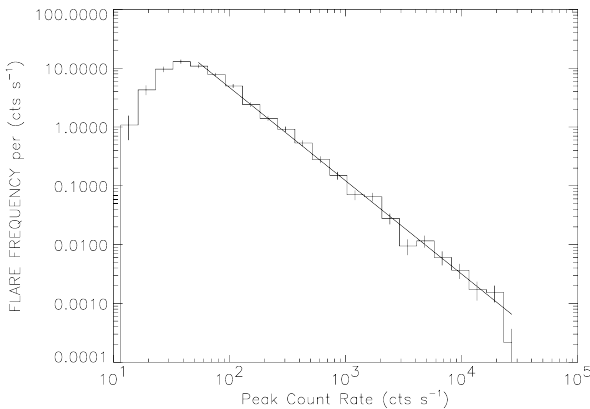
Fig.11. The frequency distribution of the bursts total duration for the whole observing period, and the fitting by either a single power-law with a slope ( γ = -1.08+/-0.03) with an exponential roll-over at T max = Fig. 1a. The frequency distribution of the WATCH total duration 2100 +/- 100 s (dotted line) or by two power-laws with slopes: β 1 = for the total observing period, that can either be represented by one -1.09+/-0.05 and β 2 = -2.28 +/- 0.08 (full lines). single power-law with an exponential roll-over or by two power- laws. From Crosby et al. (1998). Table 5. Characteristics of the frequency distributions in peak count N. Crosby et al.: Deka-keV X-ray observations of solar bursts with WATCH/GRANAT 309 rates for sub-groups of events.